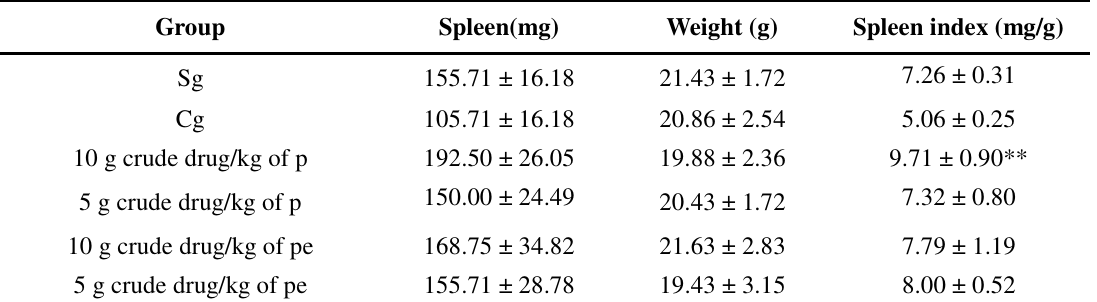
Table 4. Evaluation of polysaccharide on spleen index in tumor-bearing